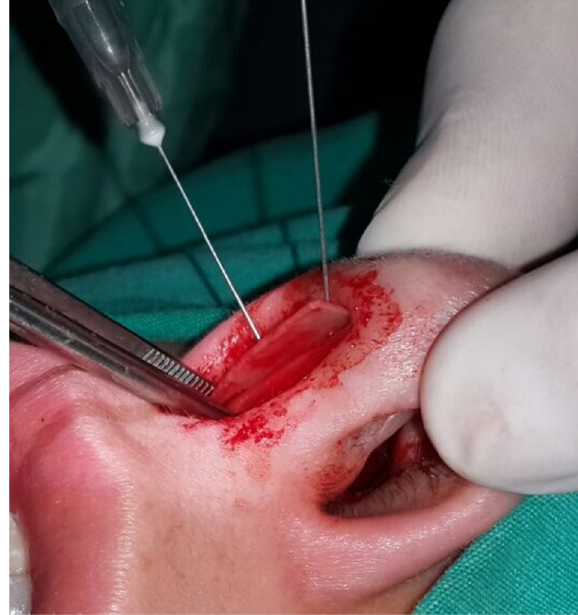
Figure 3 Application of caudal septal extension graft